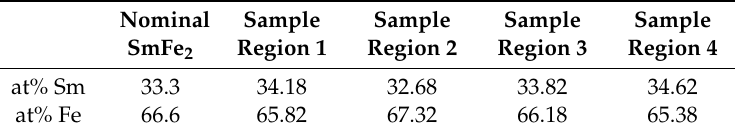
Table 1. EDS of the ribbon sample measured in different regions.